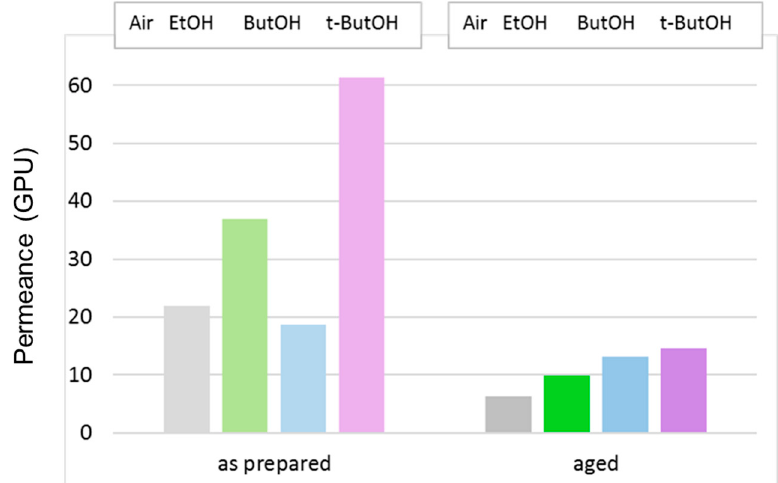
Figure 13. CO 2 permeance (GPU) in T1 membranes that were dried in air or solvent-exchanged. Tests carried out just after the preparation or after long-term aging.